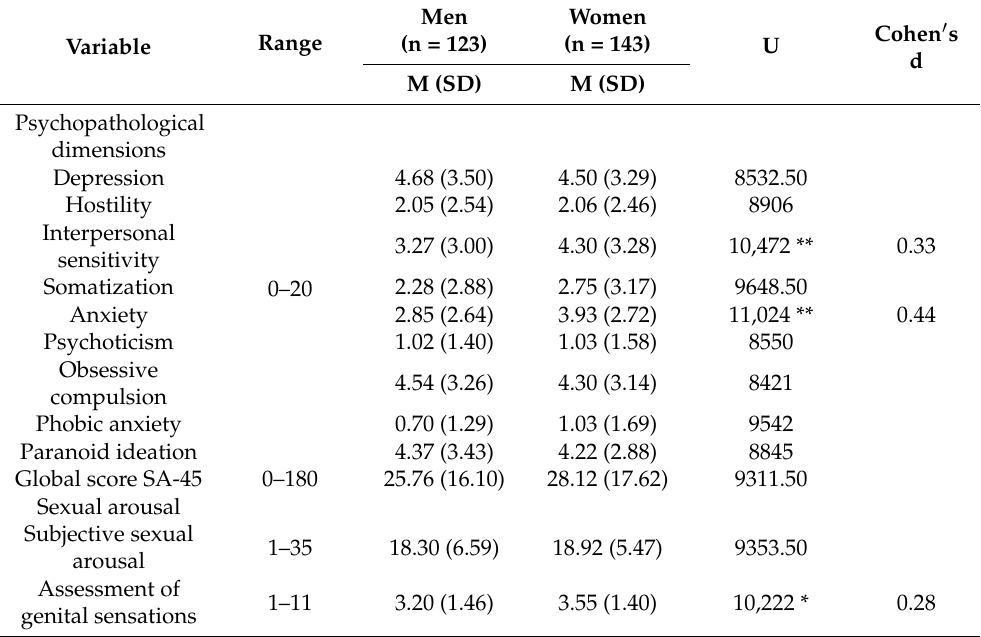
Table 6. Differences between men and women in the psychopathological dimensions, subjective sexual arousal, and assessment of genital